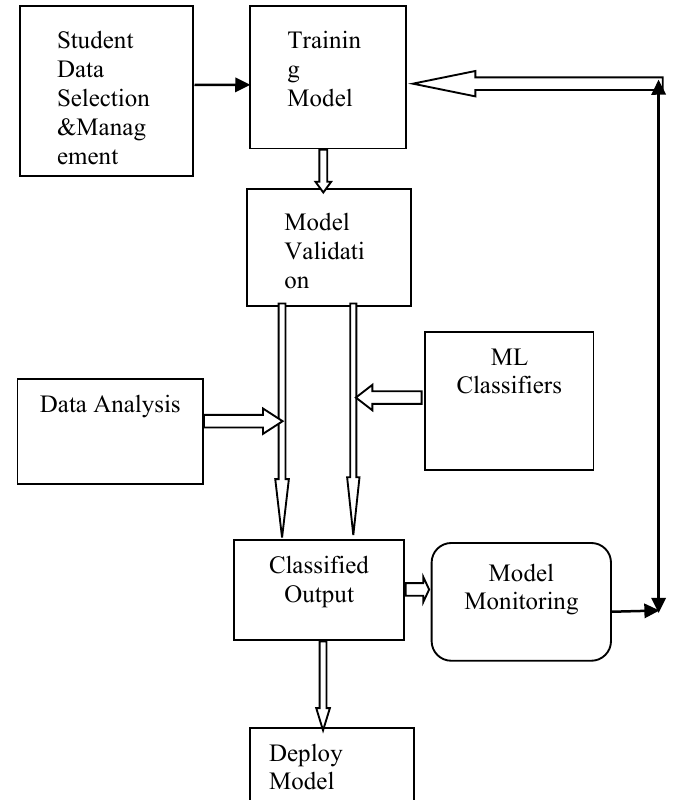
Figure 1. Architectural Framework